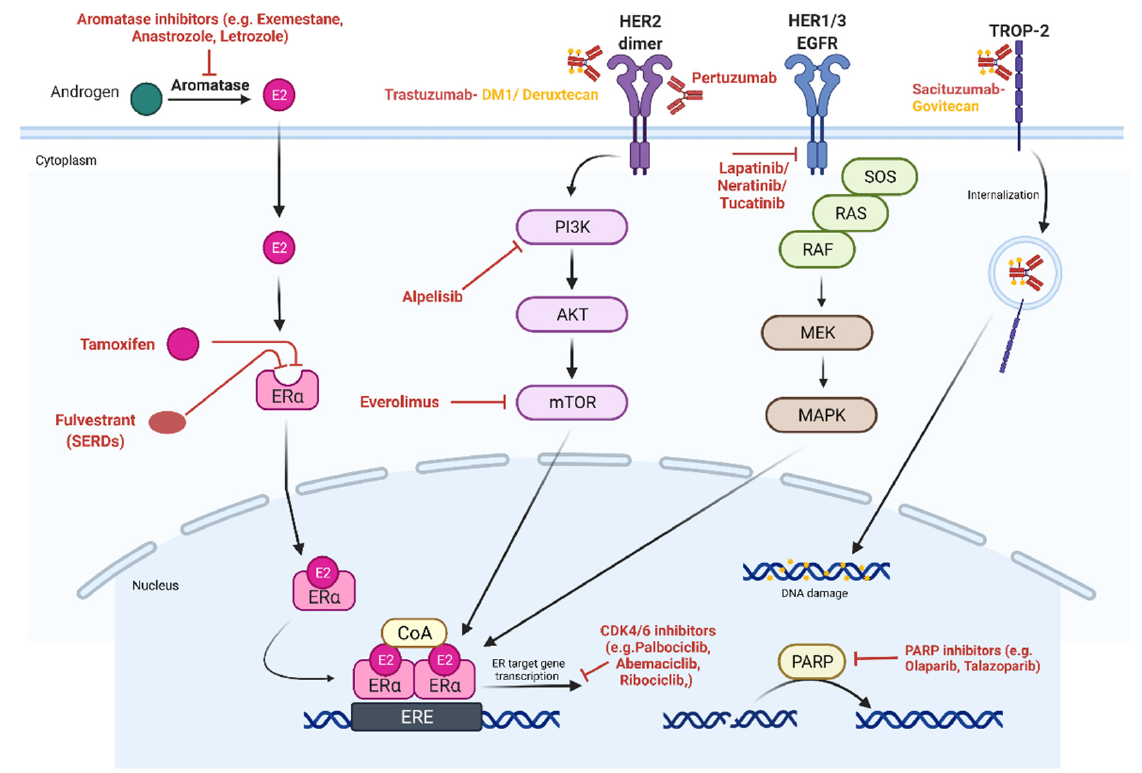
Figure 1. Therapeutic molecular targets in breast cancer. ER (estrogen receptor), SERD (selective estrogen receptor degrader), HER1/2 (human epidermal growth factor receptor 1/2), EGFR (epidermal growth factor receptor), and TROP-2 (trophoblast cell surface antigen 2).